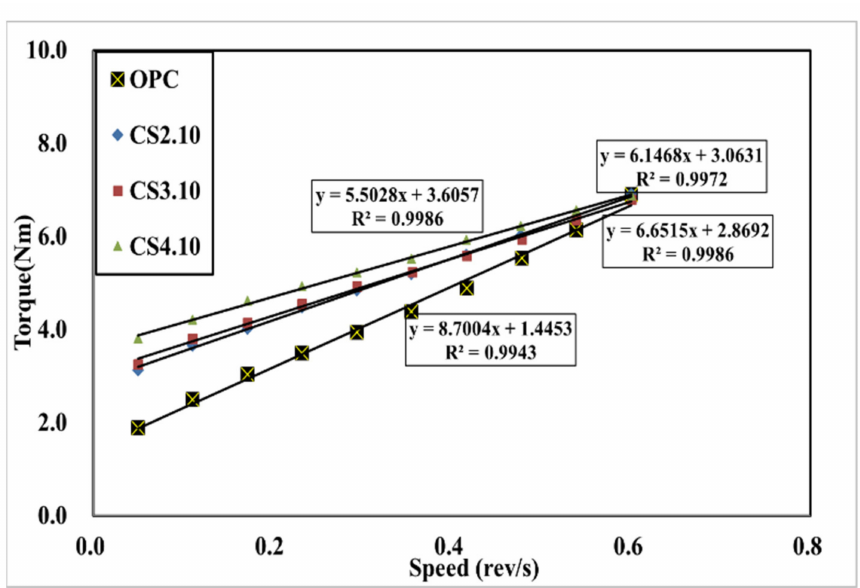
Figure 7. Rheological measurement results according to the mixing ratio of colloidal silica.